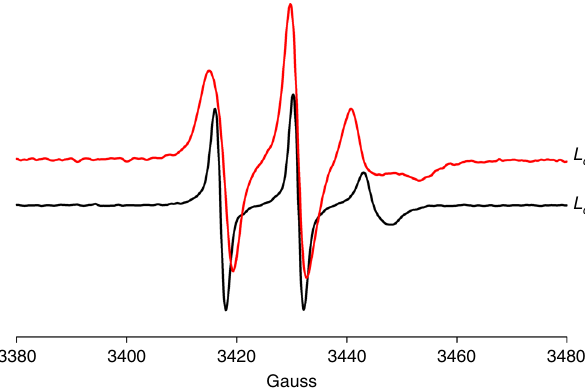
Fig. 6 EPR spectra of DPPC/DOPC/chol. Spectra are of 16:0 – 16 Doxyl PC, added to DPPC at 1 mol%, in DPPC/DOPC/chol, 0.24/0.69/0.07 ( L o , red), and DPPC/DOPC/chol, 0.24/0.69/0.07 ( L d , black), recorded at 298 K in pure nitrogen. The increased linewidth, in particular of the M I = − 1 (right) resonance in the spectrum, is a re fl ection of a higher immobilization of the label in the L o phase. Source data are provided as a Source Data fi